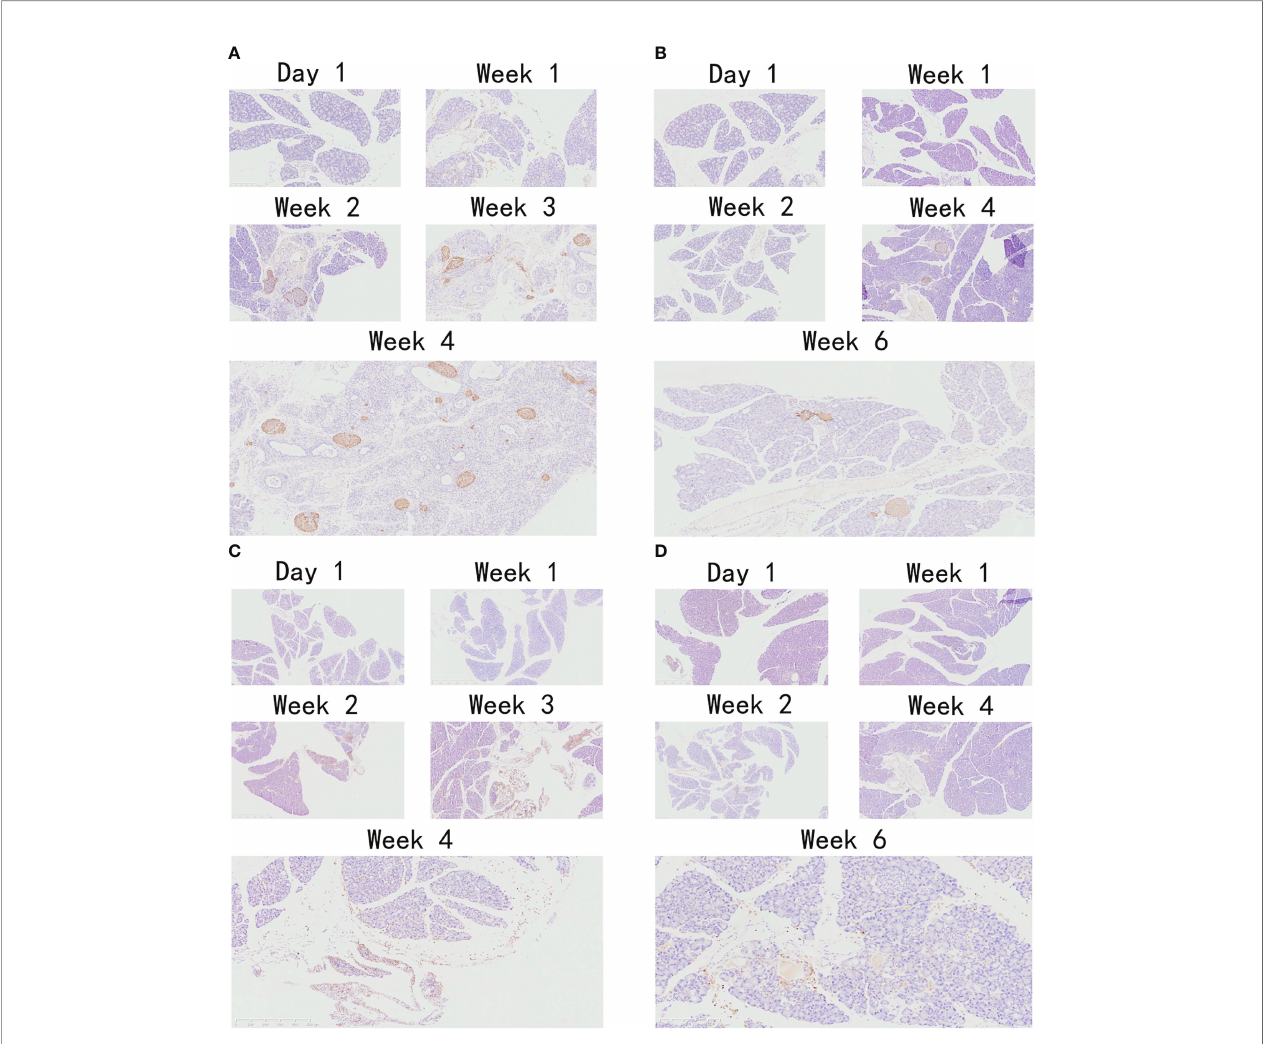
FIGURE 4 | Immunohistochemistry of T lymphocytes. (A) T lymphocytes were stained using an anti-mouse CD3 monoclonal antibody in PG. (B) T lymphocytes were stained using an anti-mouse CD3 monoclonal antibody in VG. (C) Macrophages were stained using an anti-mouse F4/80 monoclonal antibody in PG. (D) Macrophages were stained using an anti-mouse F4/80 monoclonal antibody in VG. PG, retrograde pancreatic duct injection group; VG, tail vein injection group.